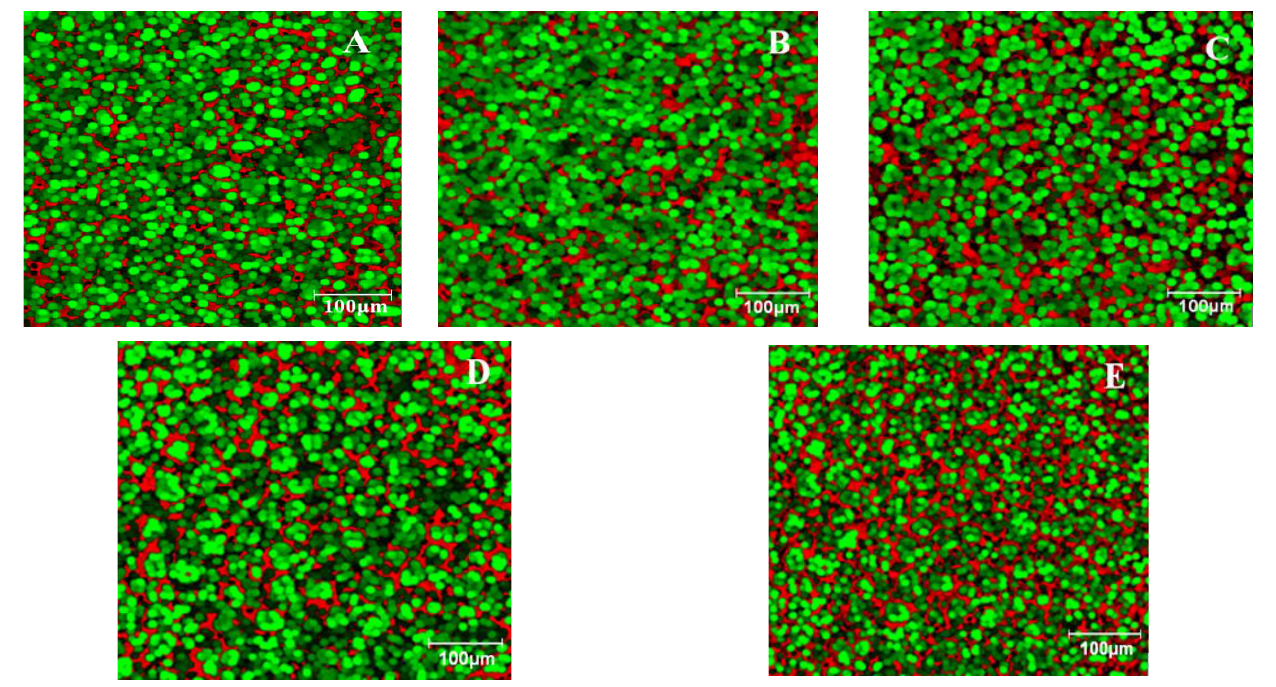
Figure 1. Microstructure obtained using EFLM of the wheat dough with LGF at different levels: 0%